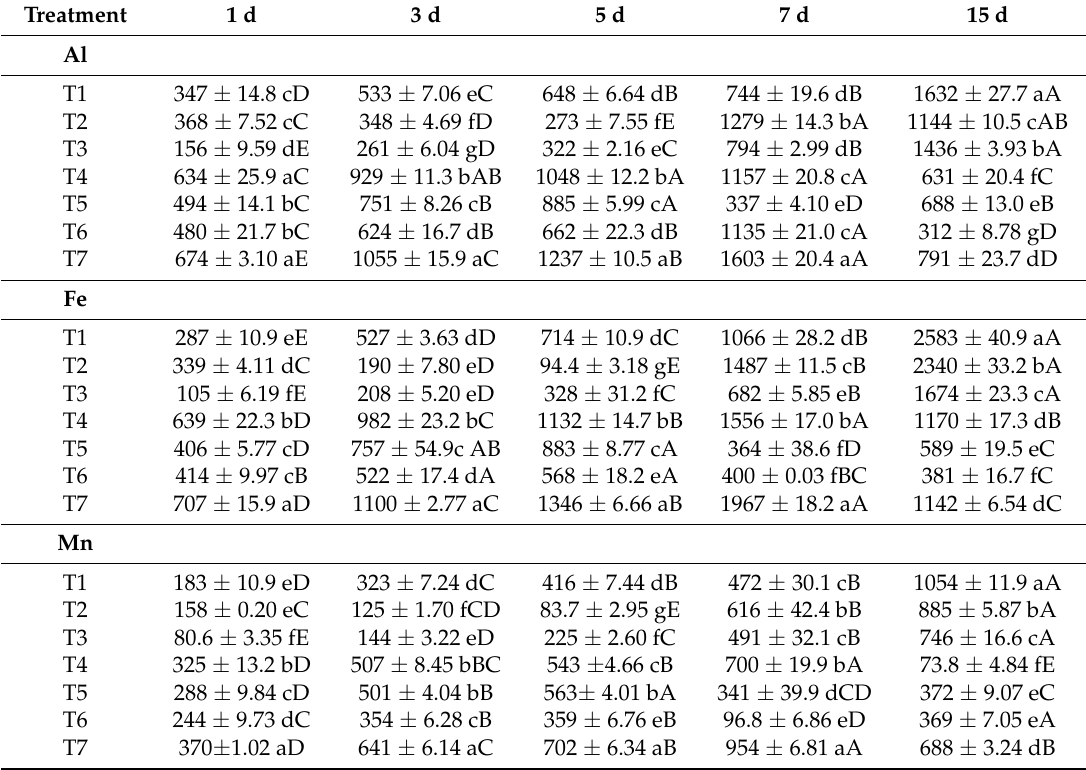
All values are presented as mean ± standard error ( n = 3). Means with different lower-case letters in the same column for each parameter are significantly different at p < 0.05. Means with different capital letters in the same